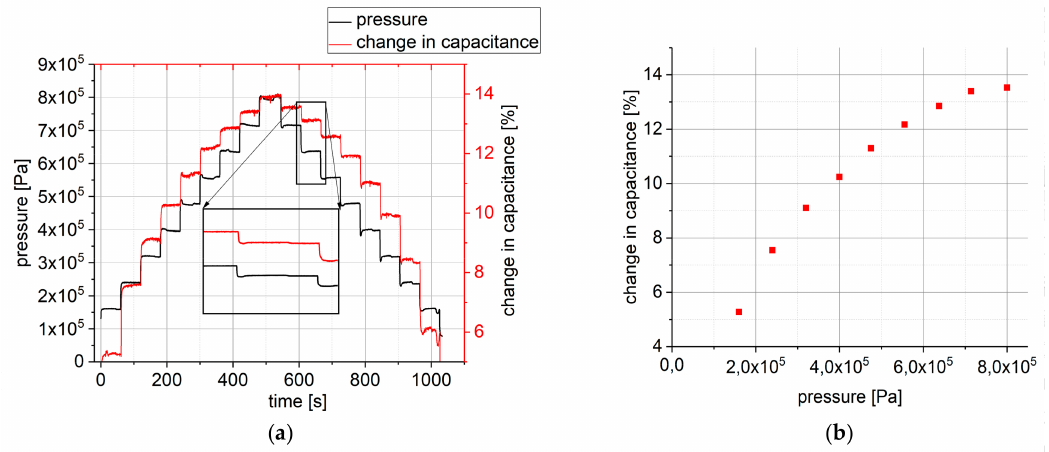
Figure 4. ( a ) The pressure (black) and change in capacitance (red) as a function of time. Each pressure level is held for one minute; and ( b ) Change in capacitance at each pressure